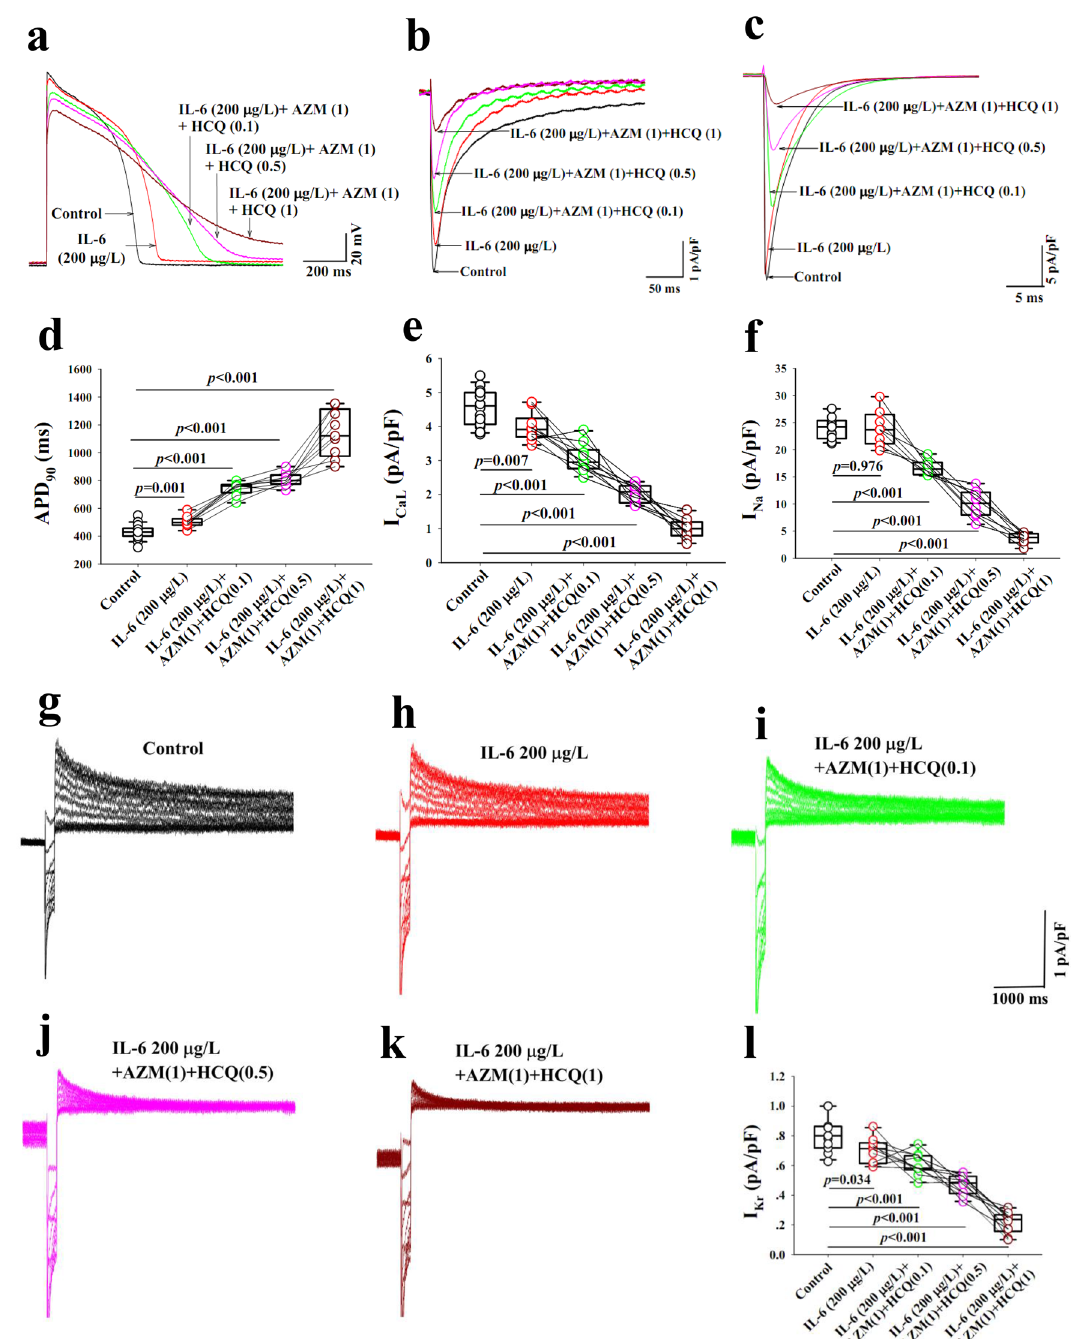
Figure 5. Impact of interleukin-6, azithromycin and hydroxychloroquine on action potential and key ion channels in guinea pig ventricular myocytes. Action potentials ( a ) and ion currents, I CaL ( b ), I Na ( c ) and I Kr ( g–k ) recorded from control myocytes (black traces) and from another group of myocytes preincubated with IL-6 for 40 min (red traces), IL-6(200 µg/L) + AZM (1) + HCQ (0.1) (green traces), IL-6 + AZM (1) + HCQ(0.5) (pink traces) and IL-6 + AZM(1) + HCQ(1) (dark red traces). The comparison of individual data points for APD 90 ( d ) and current densities for I CaL ( e ), I Na ( f ) and I Kr ( l ) during control and after different interventions is presented. HCQ(0.1) = 5.0 mg/L; HCQ(0.5) = 24.9 mg/L; HCQ(1) = 49.8 mg/L; AZM(1) = 41.5 mg/L. Unpaired t-test was used between the control group and the group treated with IL-6 + AZM + HCQ. p values shown are comparison to basal